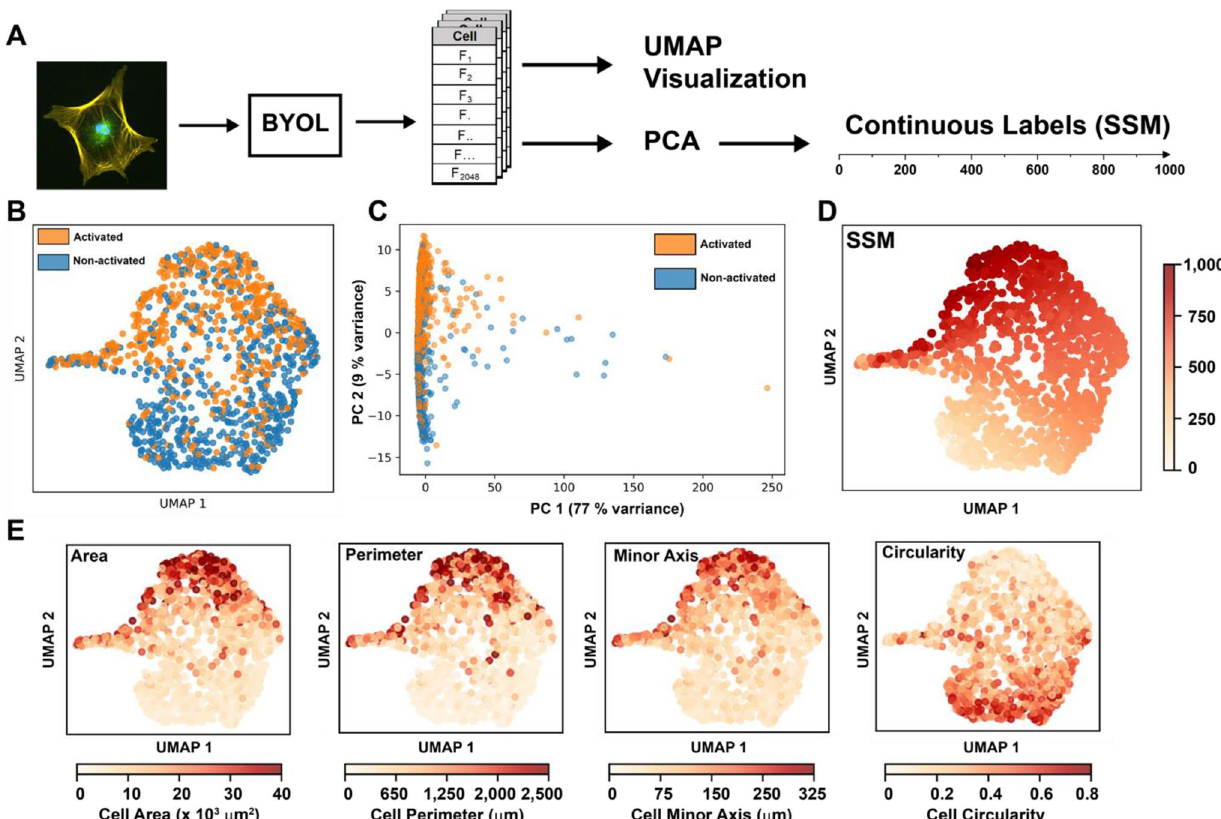
Figure 3. ( A ) Overview of the analytical pipeline. Cell images were first normalized, then used as inputs to train a BYOL model. The new abstract cell features were then visualized with UMAP, and a continuous label system was created using PCA. ( B ) UMAP reduction of the 2048 abstract features learned in the self-supervised model. ( C ) PCA reduction of the abstract cell features. ( D ) Labeling UMAP reduction by SSM labels shows a spectrum of activation. ( E ) Labeling UMAP reduction by cell features shows that this model captures similar patterns to the model in “Classifying cardiac fibroblast activation on a continuous scale”